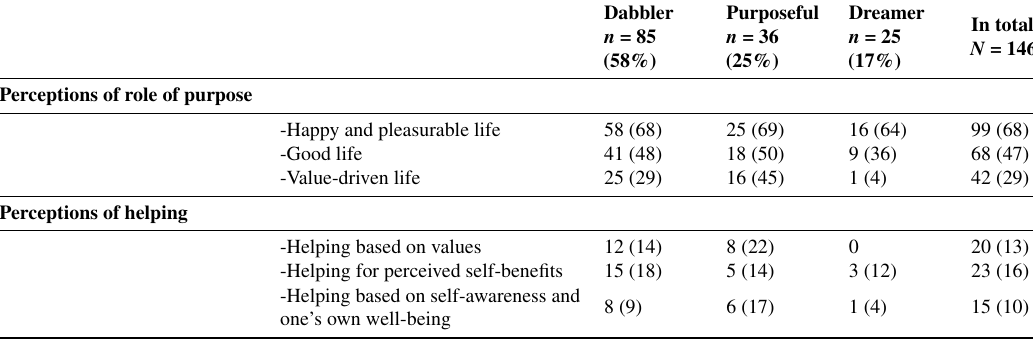
Table 5. Perceptions of role of purpose and helping in different